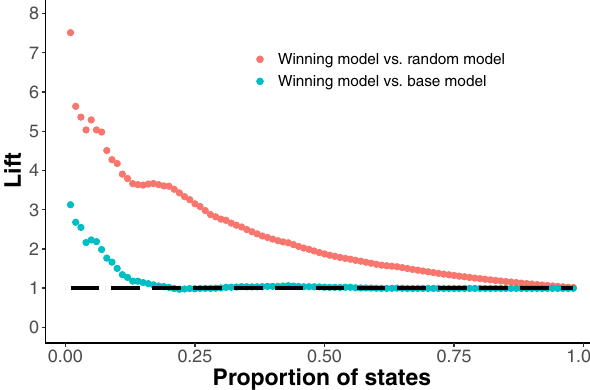
Fig. 4 Lift curves of the winning model versus the random (red) and base models (cyan). We compare the winning model, the third-ranked Poisson model of non-synonymous amino acid substitutions, against two